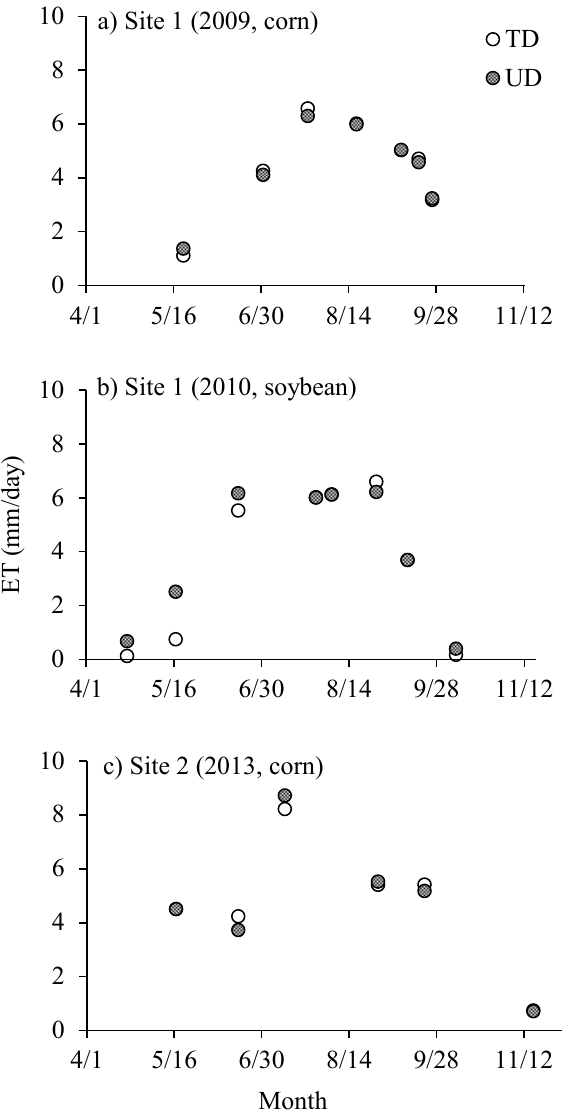
Figure 3. Comparison of daily evapotranspiration (ET) rates from the subsurface drained (TD) and undrained (UD) corn ( a , c ) and soybean ( b ) fields at satellite overpass dates. The normalized difference vegetation index (NDVI) values of TD field were greater than or equal to the NDVI values from the UD field for all 21 image dates; however, the differences were less than 0.07 (unitless). For the corn years 2009 and 2013, the maximum NDVI value of 0.78 and 0.82 (the same for both TD and UD fields) was observed on the image date 24 July 2009 and 12 July 2013, respectively. For soybean, the maximum NDVI was 0.85 from the TD field (0.83 for UD field) on 28 July